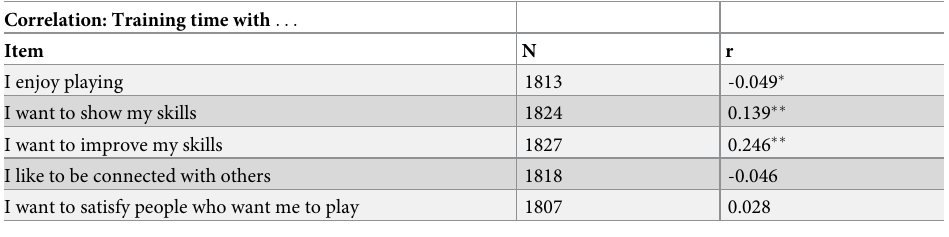
Table 19. Pearson correlation coefficients regarding the relationship of motives and training time. Correlation: Training time with